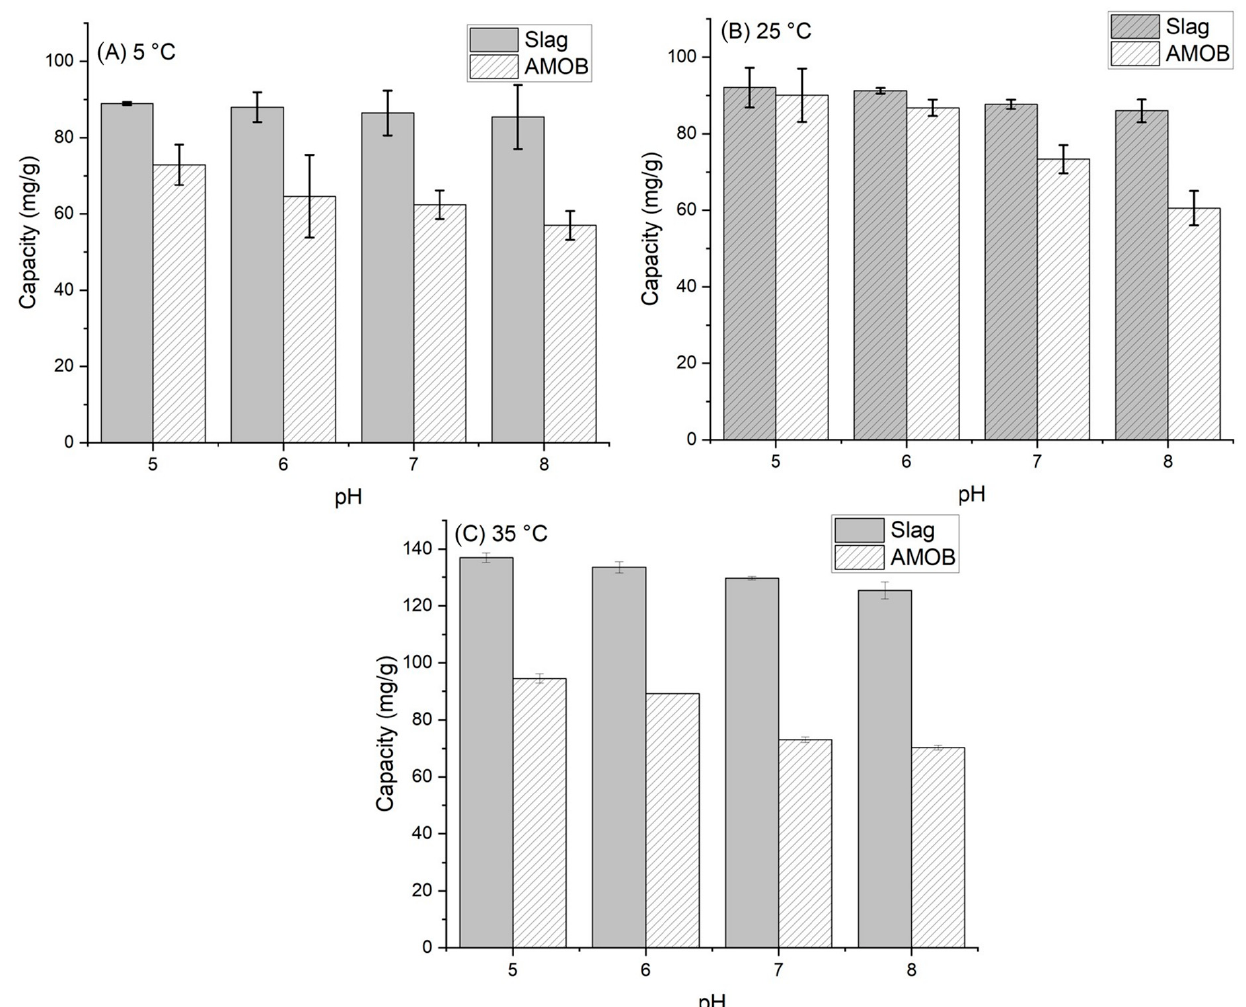
Figure 6. Sorbent adsorption capacity vs. pH for ( A ) 5 °C, ( B ) 25 °C and ( C ) 35 °C temperatures [adsorbent concentration = 0.002 g/mL; 500 mg/L PO 43 − solution; shaking time 24 h. Samples were run in triplicate].